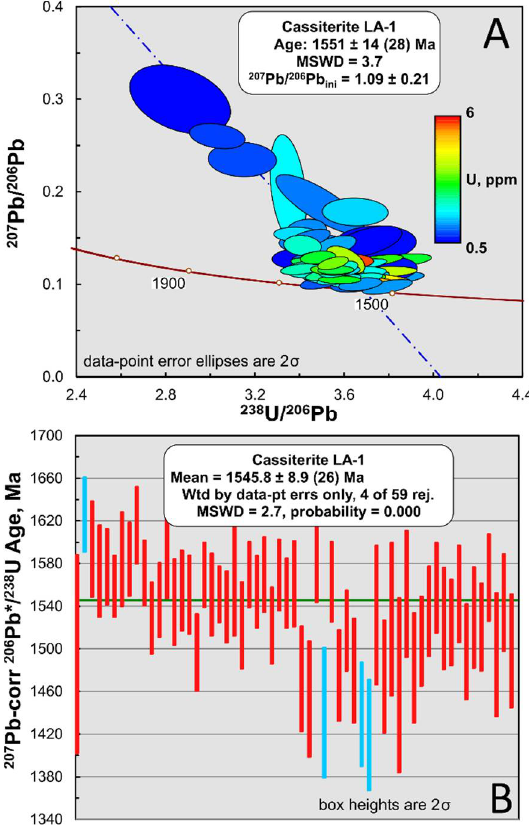
Figure 14. The U-Pb isotope data for cassiterite sample LA-1 from the Pitkäranta Mining District skarn deposit. Tera-Wasserburg isochron diagram and a weighted average of the 207 Pb-corrected 206 Pb*/ 238 U ages are shown in ( A , B ), respectively. The vertical lines in ( B ) represent age values with 2 standard error (2 SE) bars. The blue lines are outliers not included in the weighted average calculation.